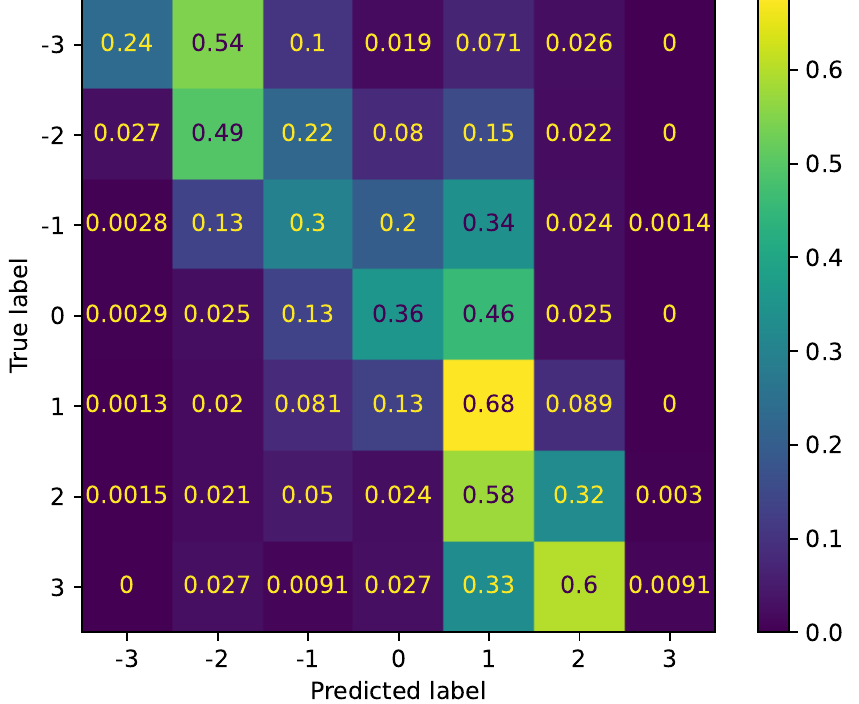
Figure 5. Normalized confusion matrix for seven-class sentiment analysis [ − 3,